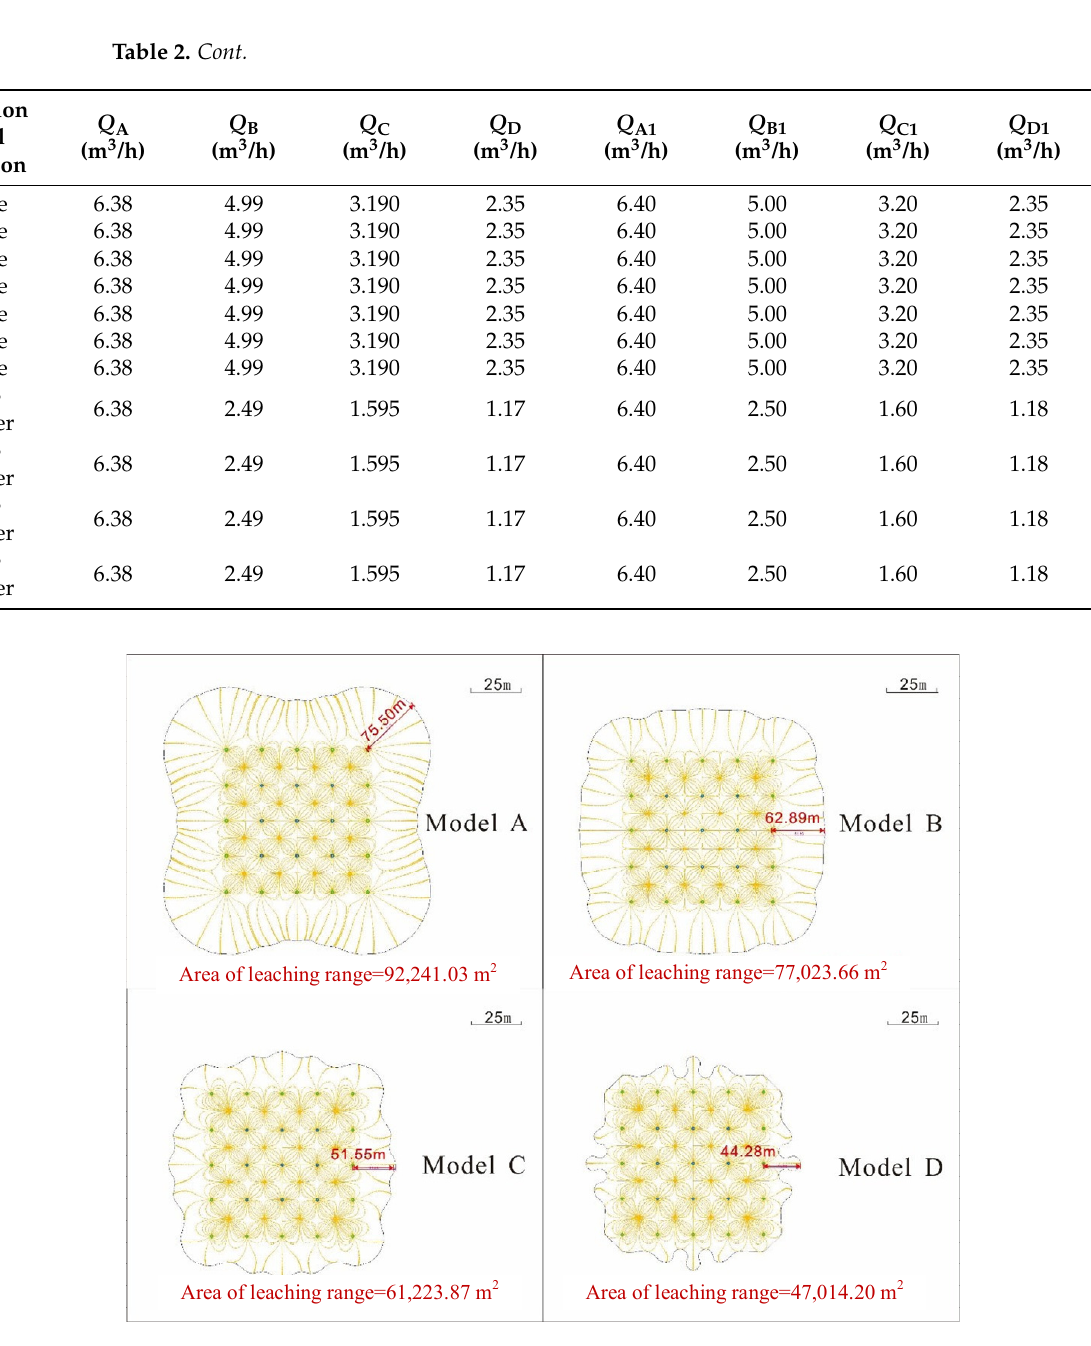
Figure 5. Comparison chart of leaching range under the 0.3% pumping injection ratio (TEF > 0.3%TIF).